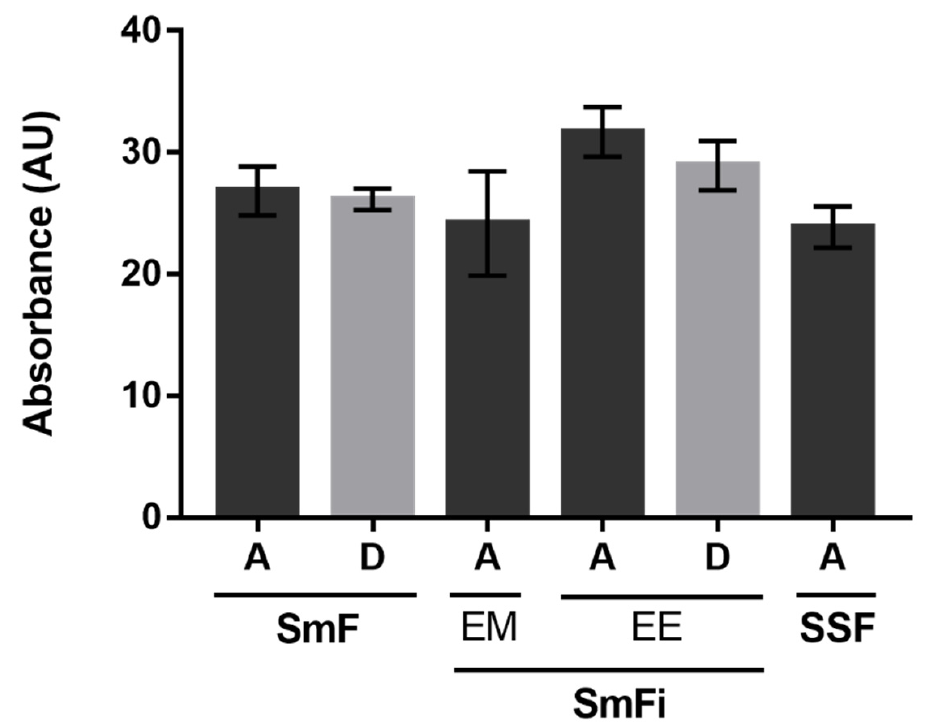
Figure 6. Values of absolute absorbance obtained from the sum of the absorbances measured at 400, 470, and 500 nm for the best conditions found under the three studied types of fermentation. (SmF) submerged fermentation; (SmFi) submerged fermentation with mycelium immobilization; (SSF) solid-state fermentation; (EM) extracellular medium; (EE) ethanolic extract of the biomass; (A) synthetic medium (dark grey); and (D) alternative medium containing cheese whey and corn steep liquor (grey). Values are the mean ± SD ( n = 3). Statistical analysis was performed by one-way ANOVA.